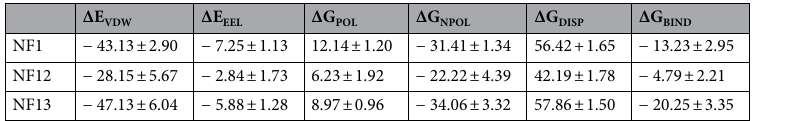
Table 3. Binding free energy estimation of compounds using MM-PBSA.